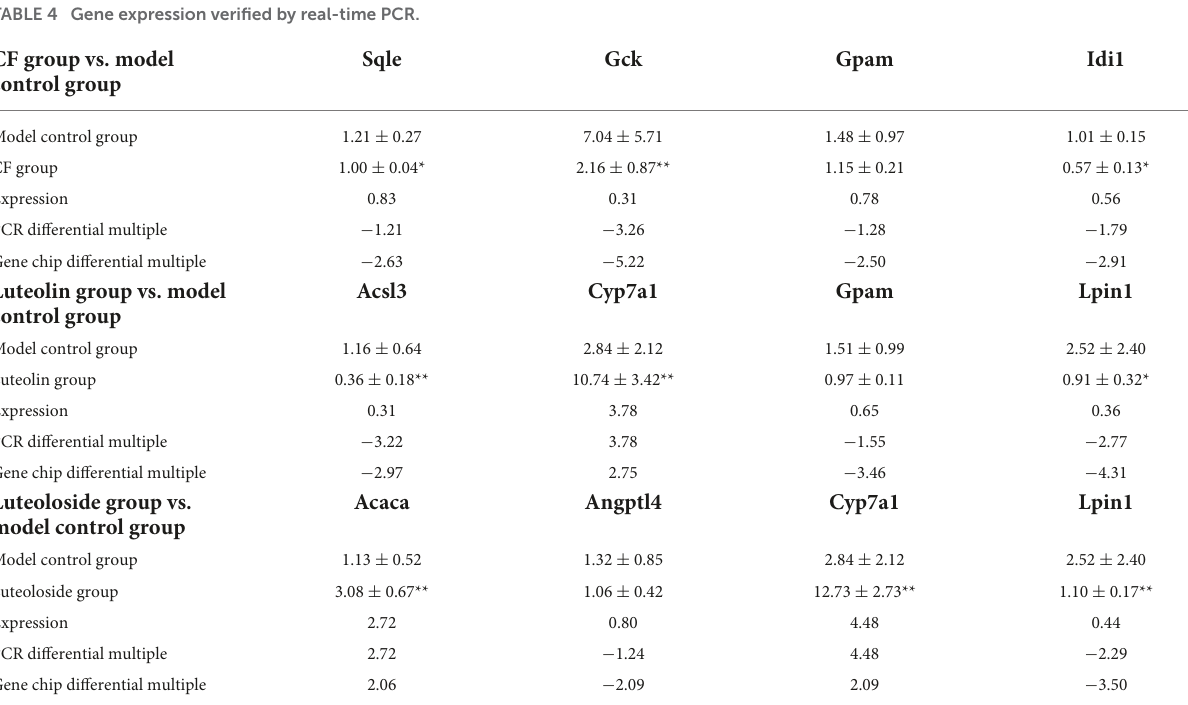
TABLE 4 Gene expression verified by real-time